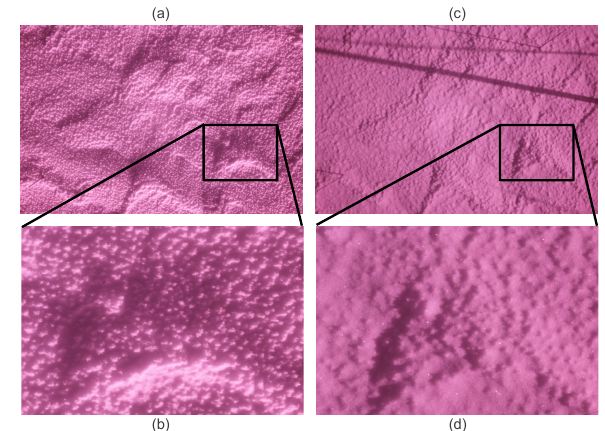
Fig. 16. Near-infrared pictures at Dome C before and after hoar disappearance caused by burying or capture of fresh snow. (a) and (b) 7, (c) and (d) 9 January 2011.